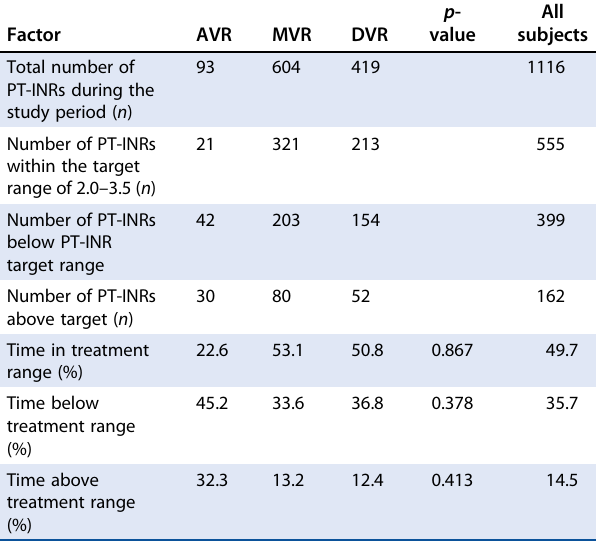
Table 3: PT-INR-specific frequency of all valve-related complications PT- INR range